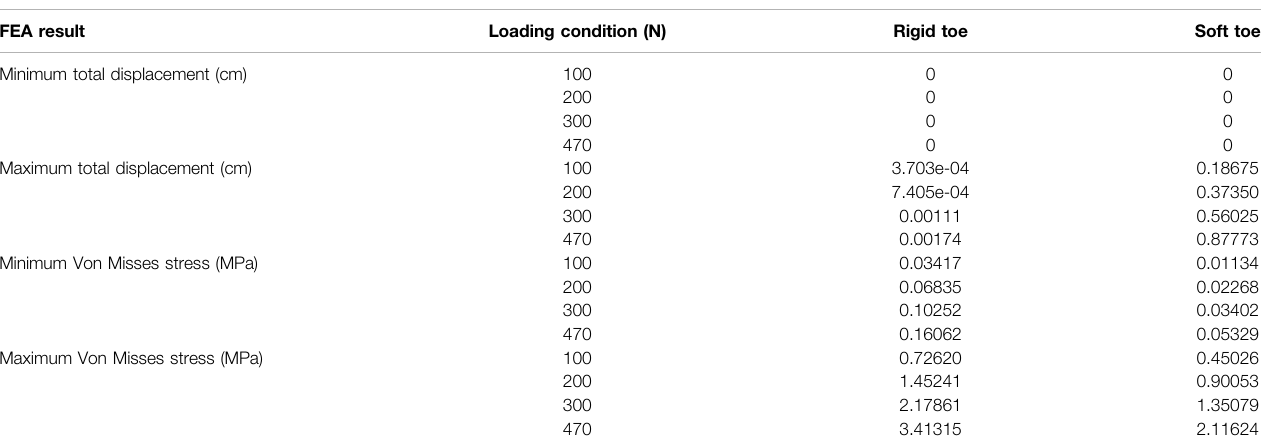
TABLE 3 | A comparative overview of FEA results for the rigid and the soft